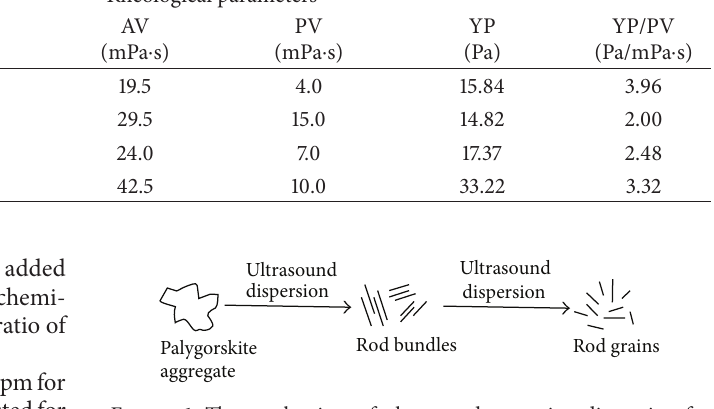
Figure 1: The mechanism of ultrasound scattering dispersion for palygorskite